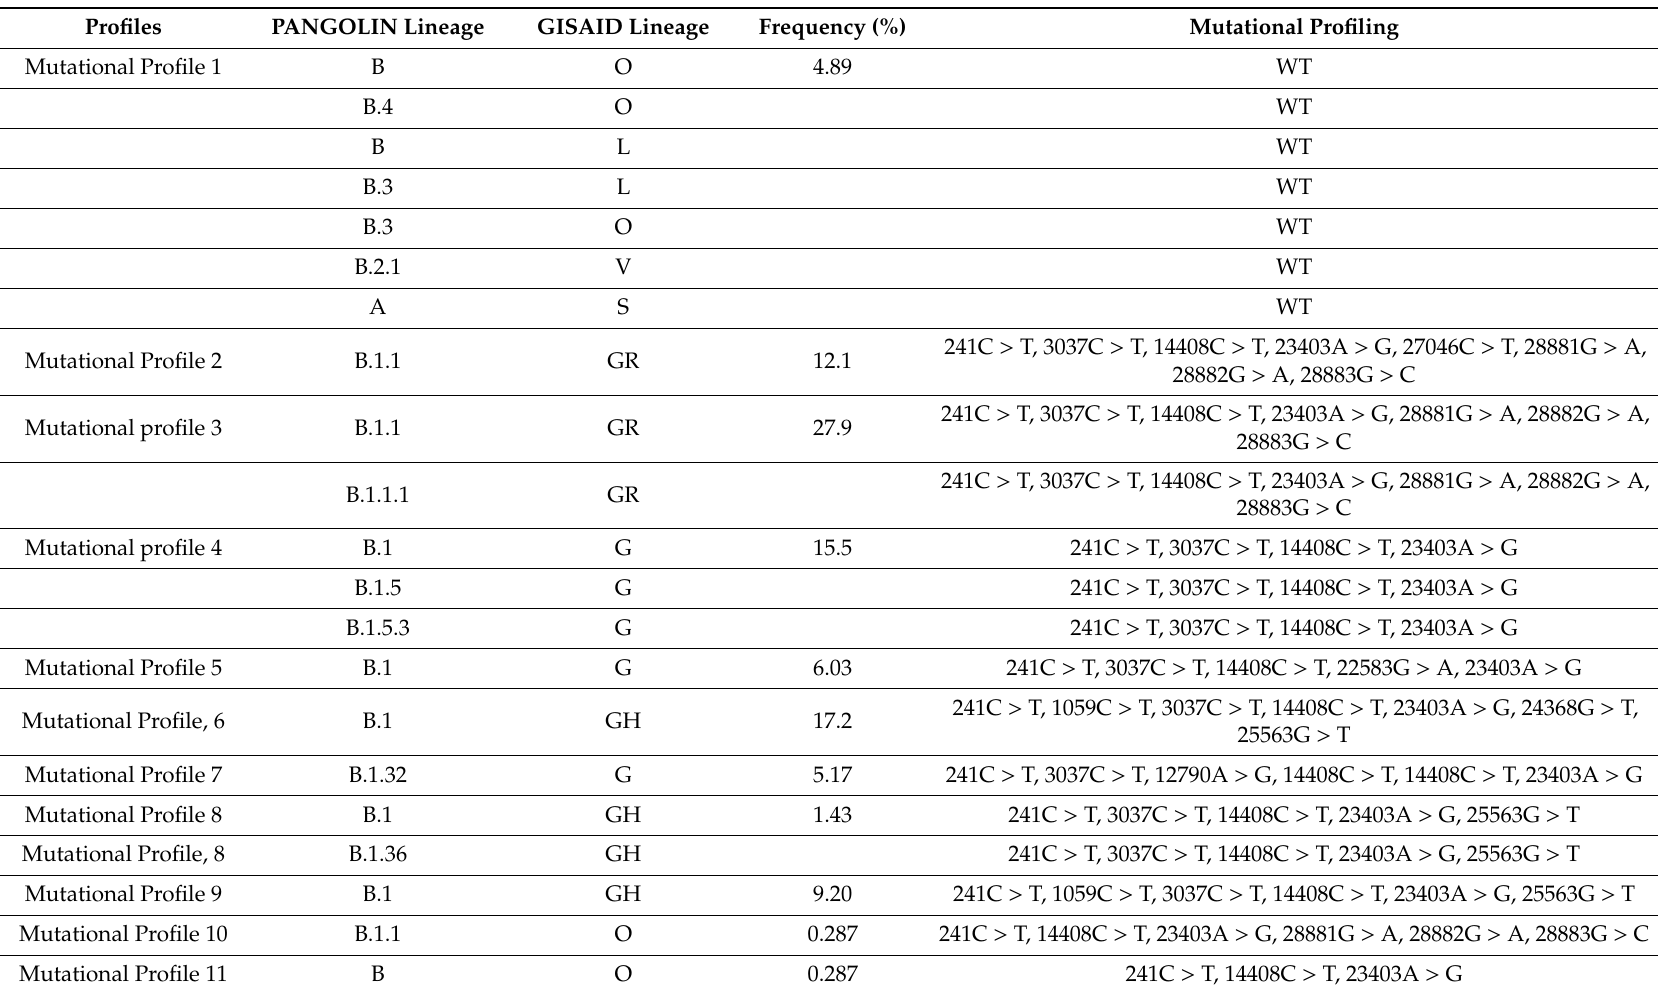
Table 2. Mutational profiles observed in Swedish